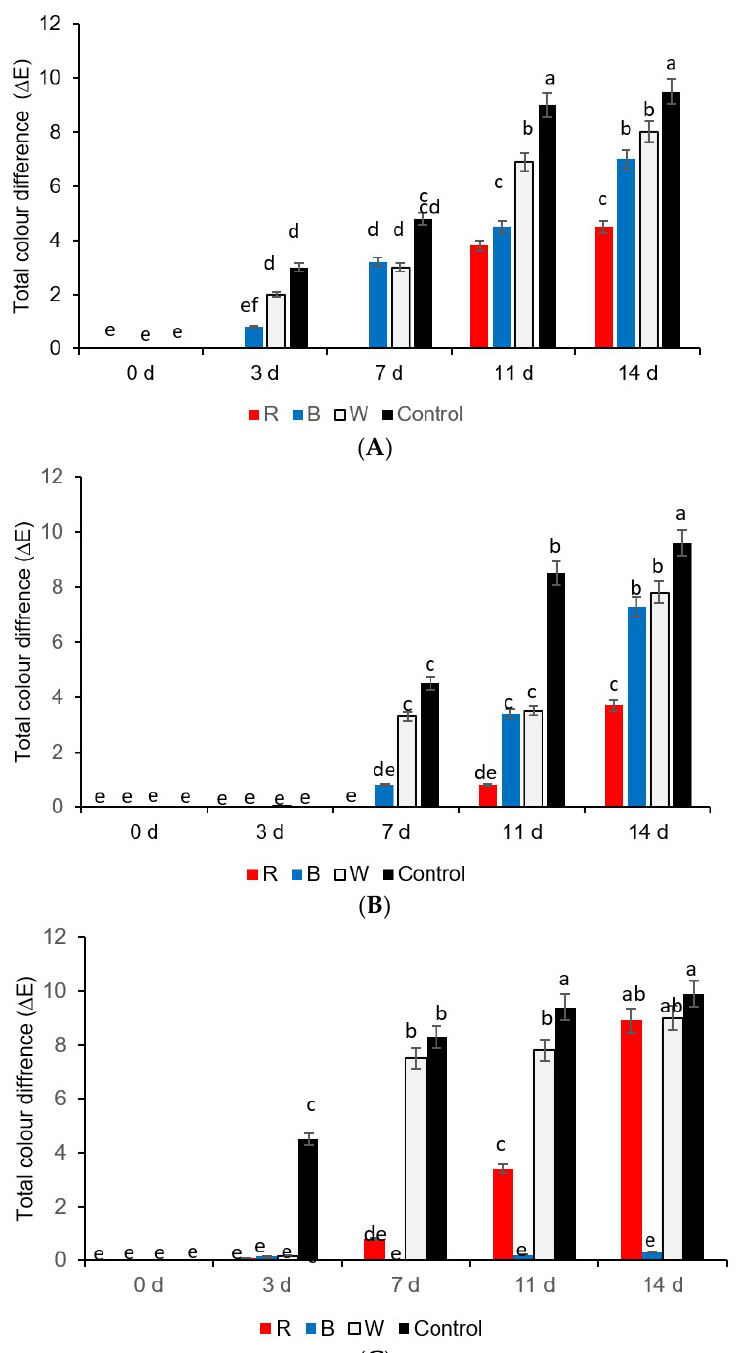
Figure 3. Total color changes in ( A ) yellow, ( B ) green, and ( C ) red sweet pepper fresh-cuts exposed to LED treatments. R—Red, B—Blue, W—White light; Control—Darkness. Data include 0, 3, 7, 11, and 14 days storage time. Different letters above each bar indicate significant differences ( p < 0.05) using Fisher’s LSD test.